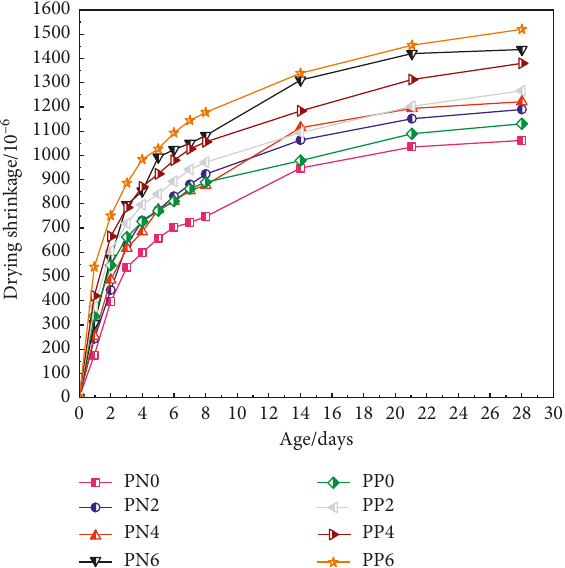
Figure 10: The drying shrinkage of the plastic mortar vs curing time.